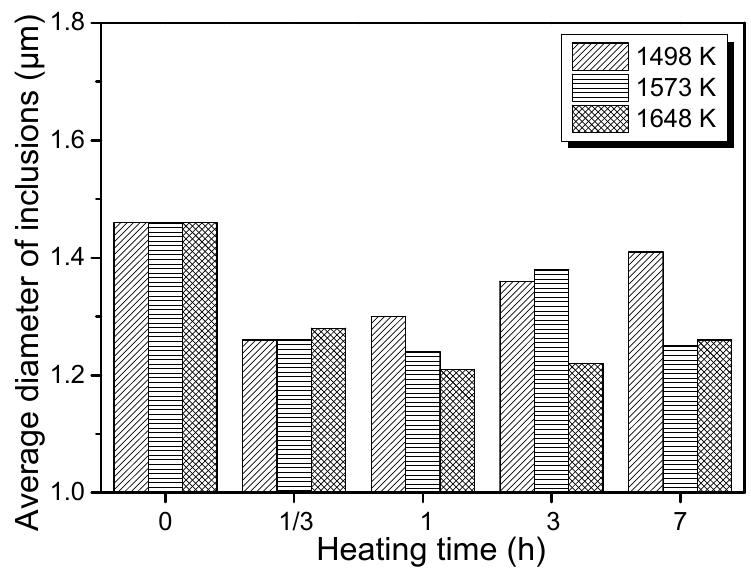
Figure 16. E ff ect of holding time and temperature on the size of inclusions in the steel during heat treatment.